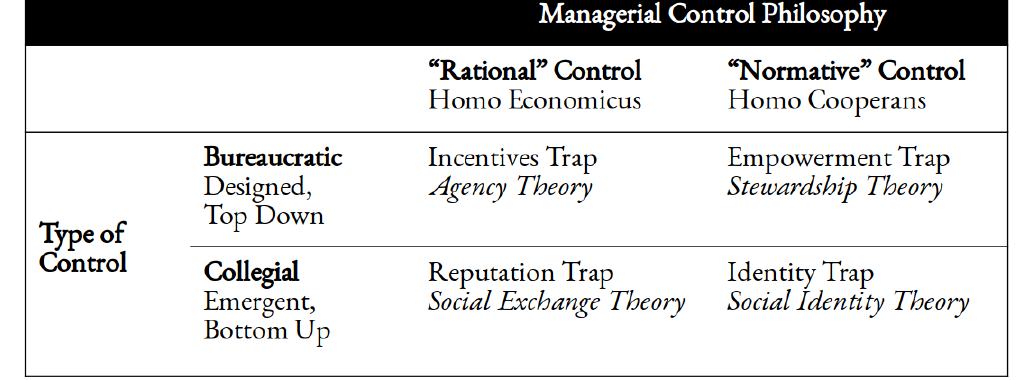
Table 1. Four control paradigms and their governance